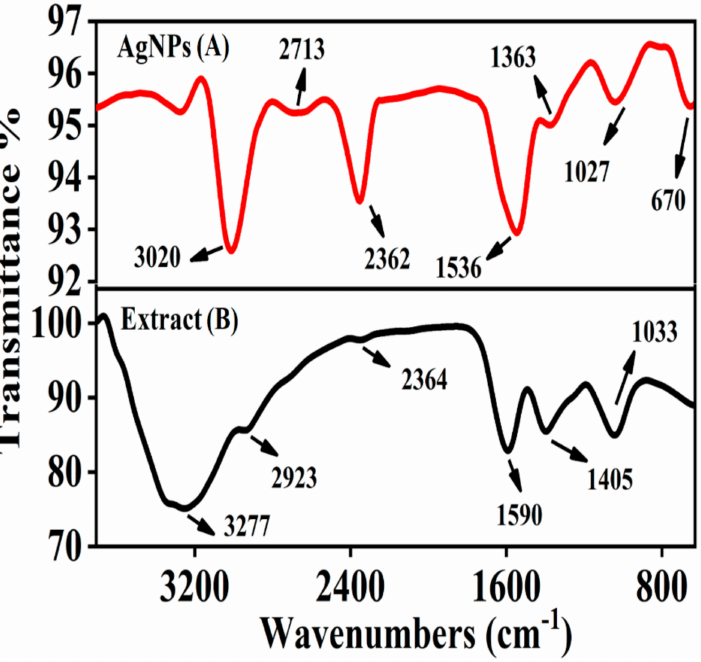
Figure 7. FTIR spectra of synthesized AgNPs ( A ) and S. procumbens plant extract ( B